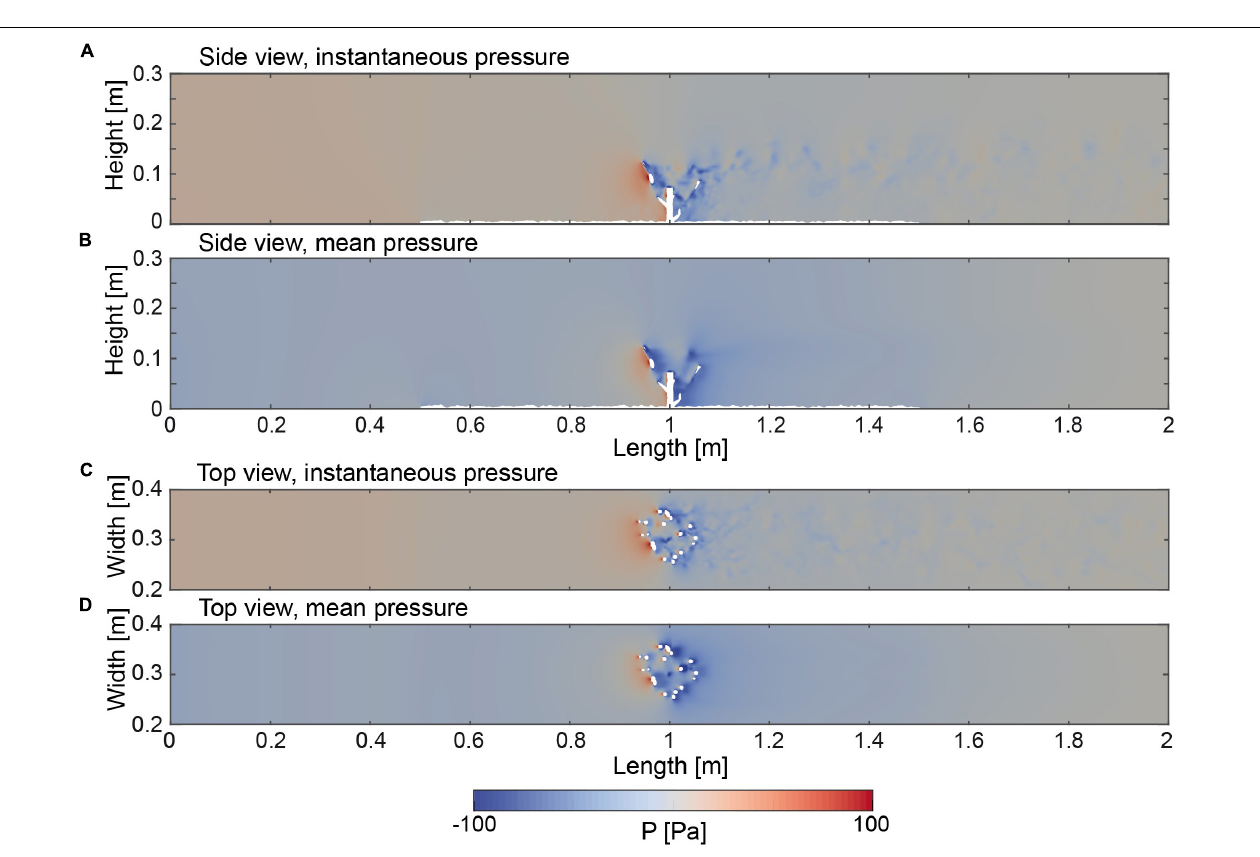
FIGURE 7 | (A) Side view ( Y = 0.15 m) indicating the instantaneous pressure field at 25.0 s. (B) Side view ( Y = 0.15 m) of the time averaged pressure field. (C) Top view ( Z = 0.05 m) indicating the instantaneous pressure field at 25.0 s. (D) Top view ( Z = 0.05 m) of the time averaged pressure field.